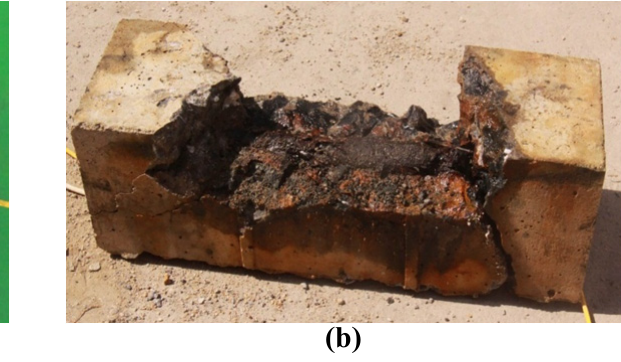
Figure 21. (a) the large cracks of specimen No.3; (b) Corrosion of the steel bar in specimen